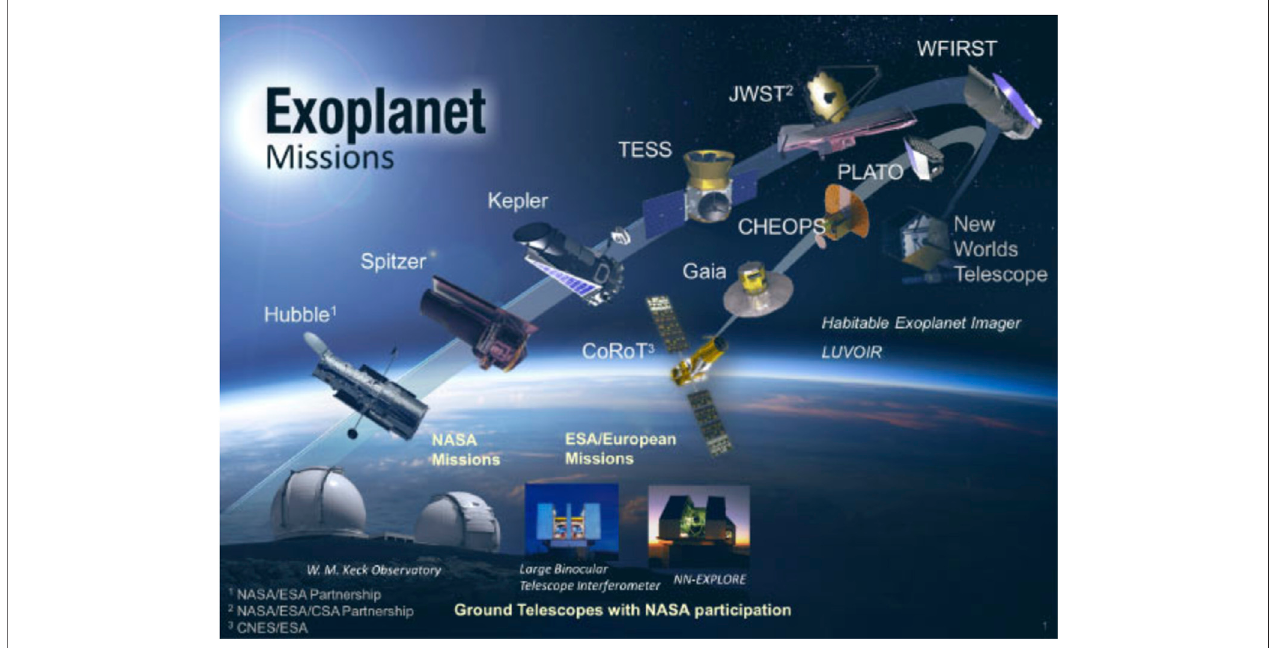
FIGURE 1 | A schematic timeline of NASA and ESA exoplanet related space missions and the ground-based follow-up telescopes NASA directly participates in. Image Credit: NASA/JPL-Caltech.